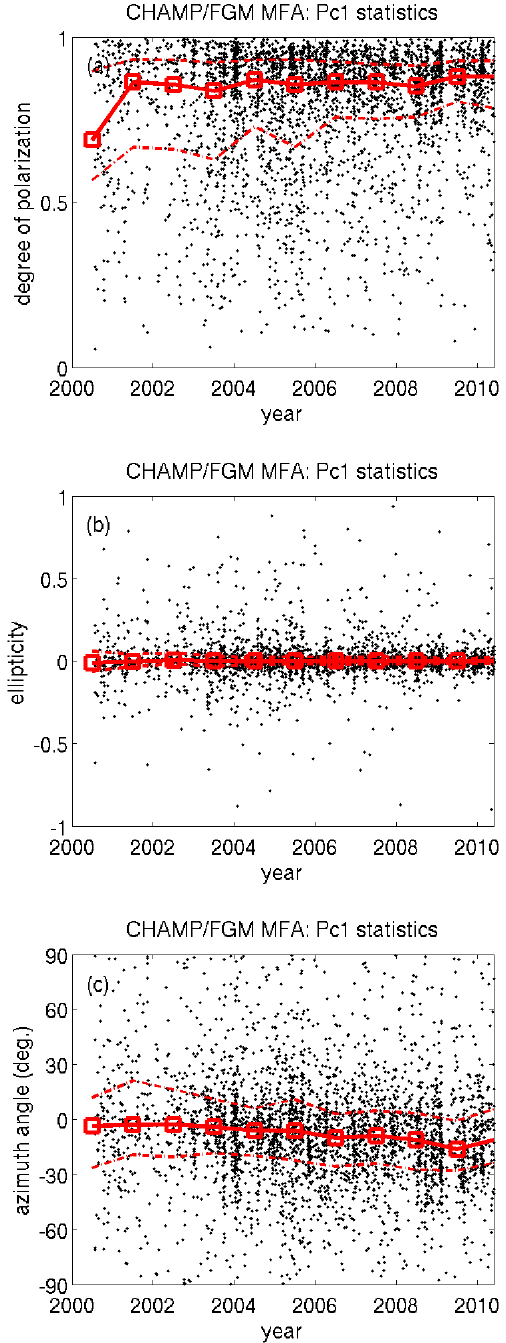
Fig. 2. Histograms of (a) center frequency, (b) bandwidth, and (c) maximum spectral amplitude of the Pc1 events detected by CHAMP/FGM.